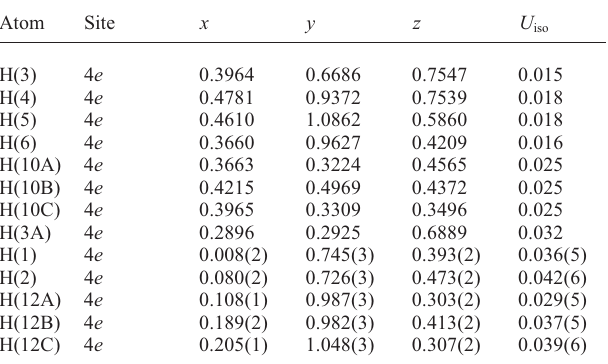
Table 2. Atomic coordinates and displacement parameters (in Å 2 )